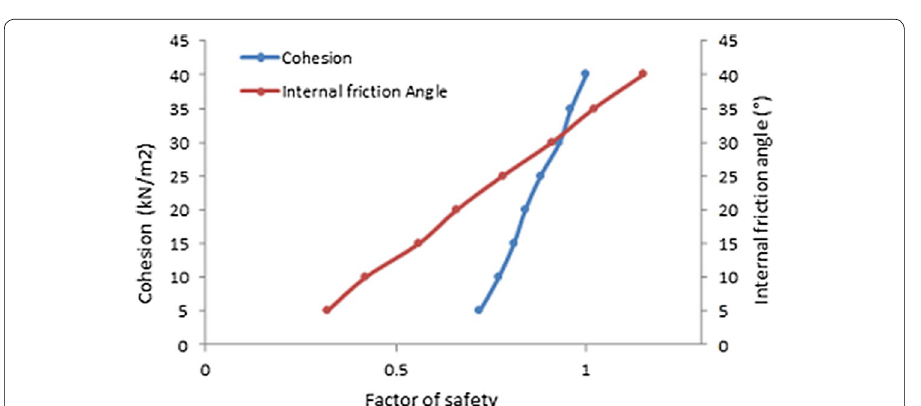
Fig. 16 Impacts of shear strength parameters on slope factor of